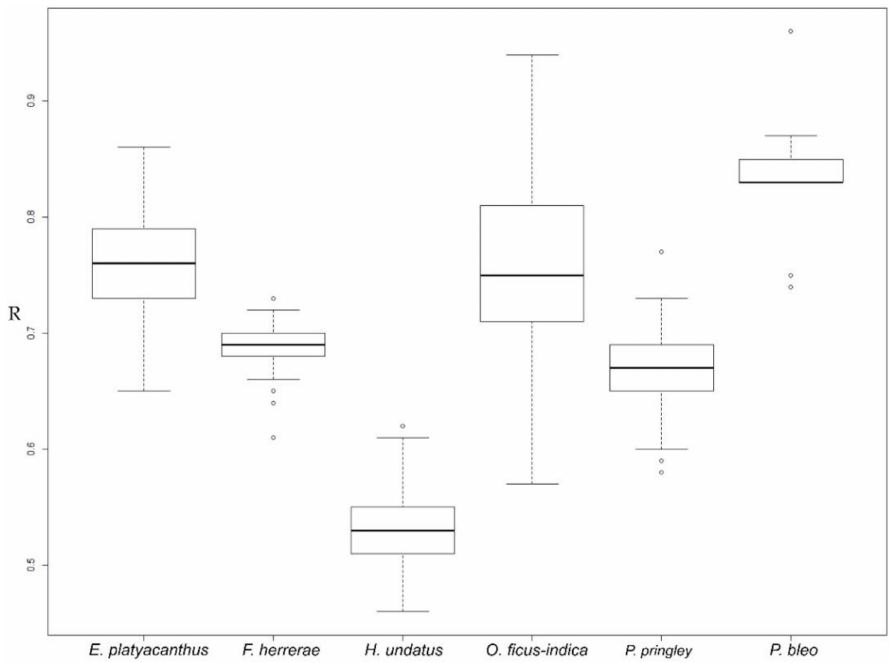
Figure A4. Values of roundness for seeds of the species Echinocactus platyacanthus , Ferocactus herrerae , Hylocereus undatus , Opuntia ficus-indica , Pachycereus pringley , and Pereskia bleo